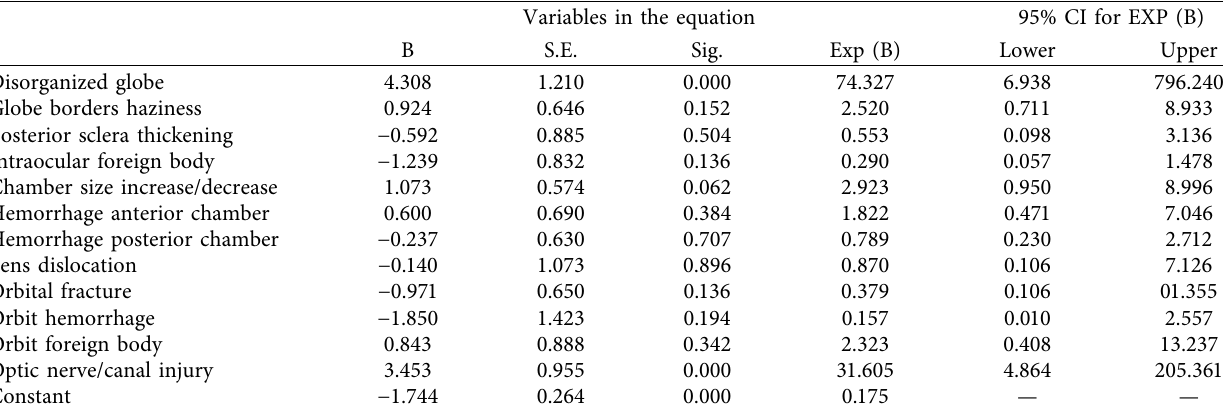
Table 4: Prognostic value of presence of CTscan findings (separately) for poor final visual acuity in patients with traumatic eye injury using binary logistic